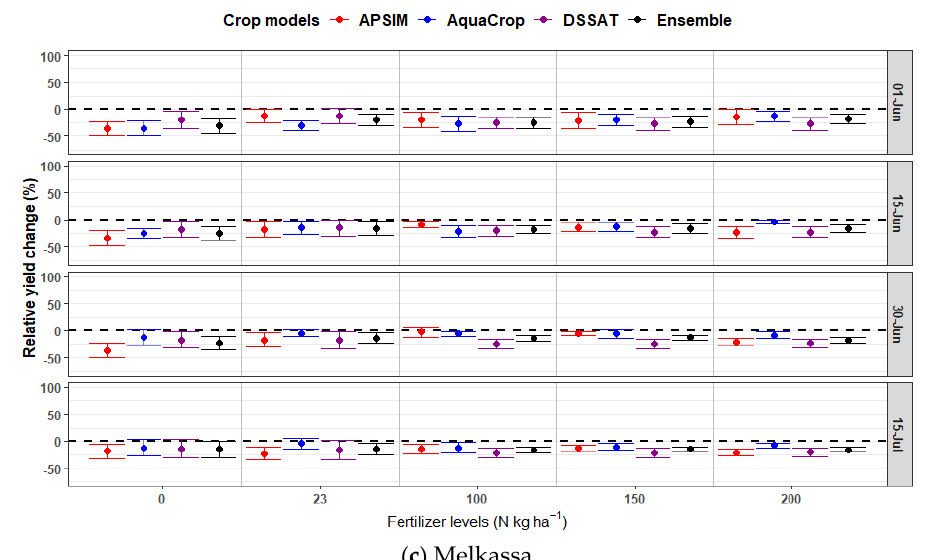
Figure 7. Crop model uncertainty in simulated mean maize yield (averaged for all cultivars) for different planting dates and nitrogen fertilizer levels for ( a ) Ambo (high-altitude), ( b ) Bako (mid-altitude), and ( c ) Melkassa (low-altitude). Error bars show the standard deviation of the change in maize yield simulated by the individual GCM projections.